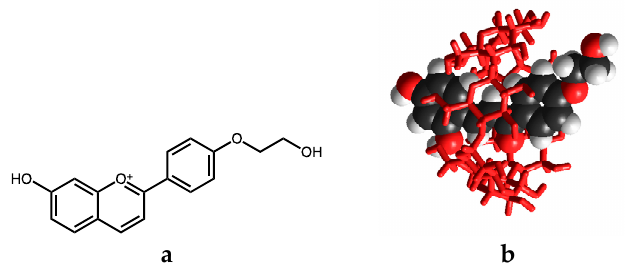
Figure 11. Circular dichroism spectra of the compound 4 ′ -(2-hydroxyethoxy)-7-Hydroxyflavylium in the presence of increasing concentrations of β - cyclodextrin at pH = 4.8 . With permission from Elsevier, reference [31]. Scheme 17. ( a ) 4 ′ -(2-hydroxyethoxy)-7-hydroxyflavylium and ( b ) possible structure of the respective trans -chalcone in the presence of β -cyclodextrin.